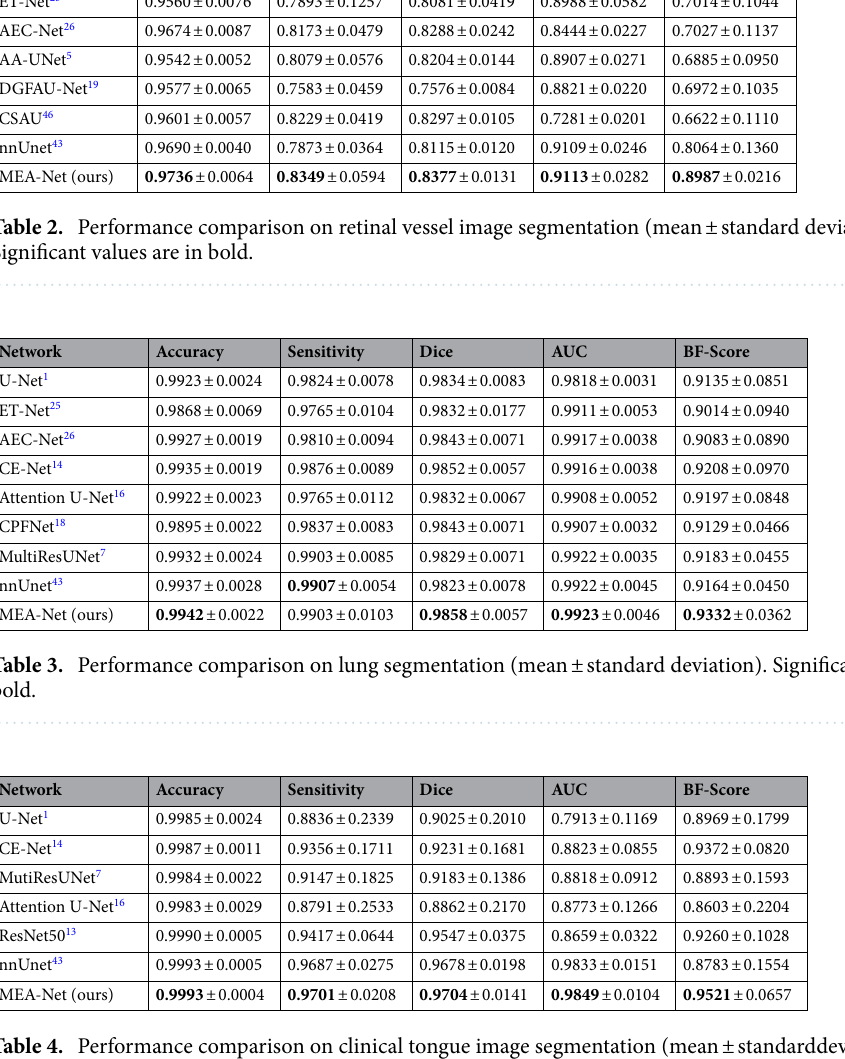
Table 4. Performance comparison on clinical tongue image segmentation (mean ± standarddeviation). Significant values are in bold.